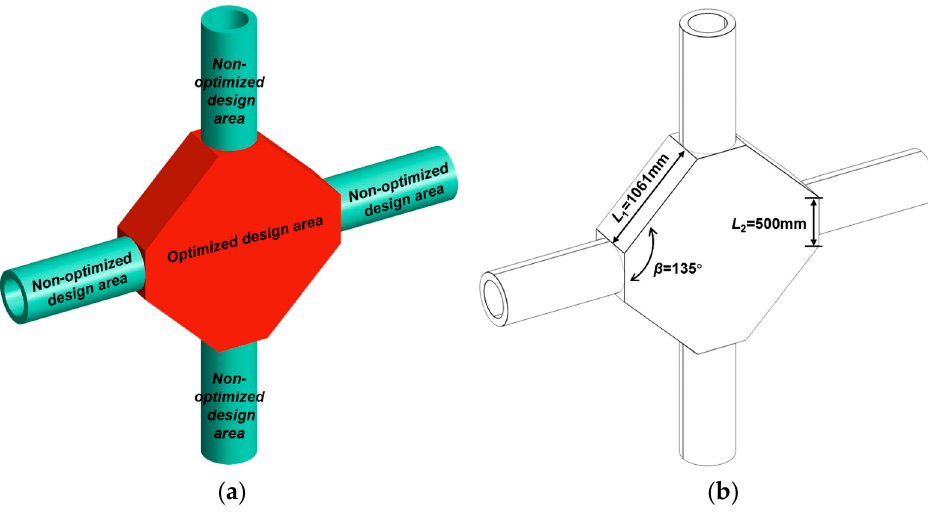
Figure 10. The flat polygon cross joint: ( a ) model, ( b ) geometric features.